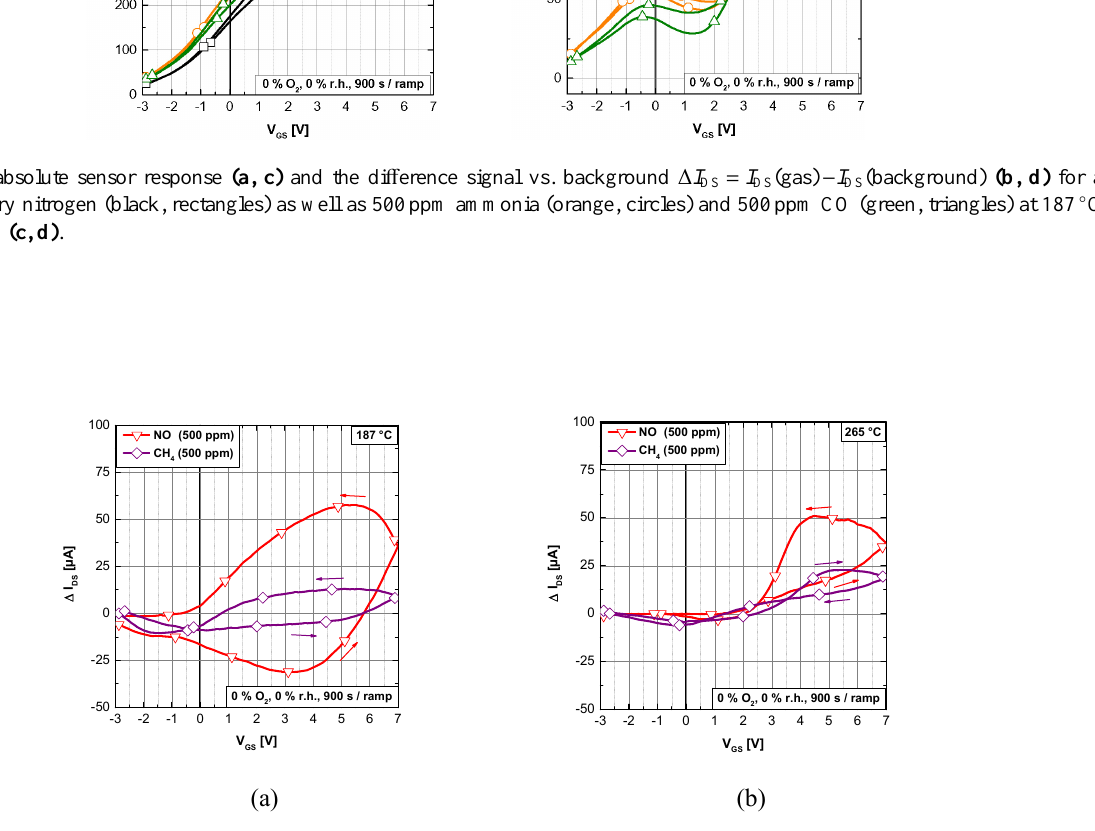
Figure 5. Hysteresis of ΔI DS for 500 ppm NO (red, triangles) and CH 4 (purple, diamonds) in 2 dry nitrogen at 187 °C (a) and 265 °C (b). 3